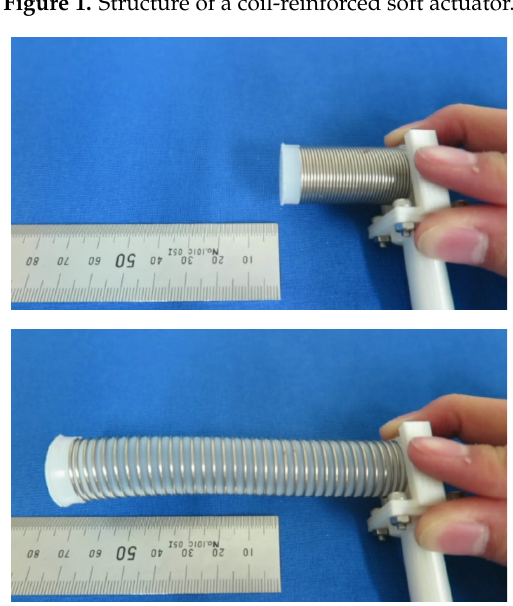
Figure 2. Prototype of a soft